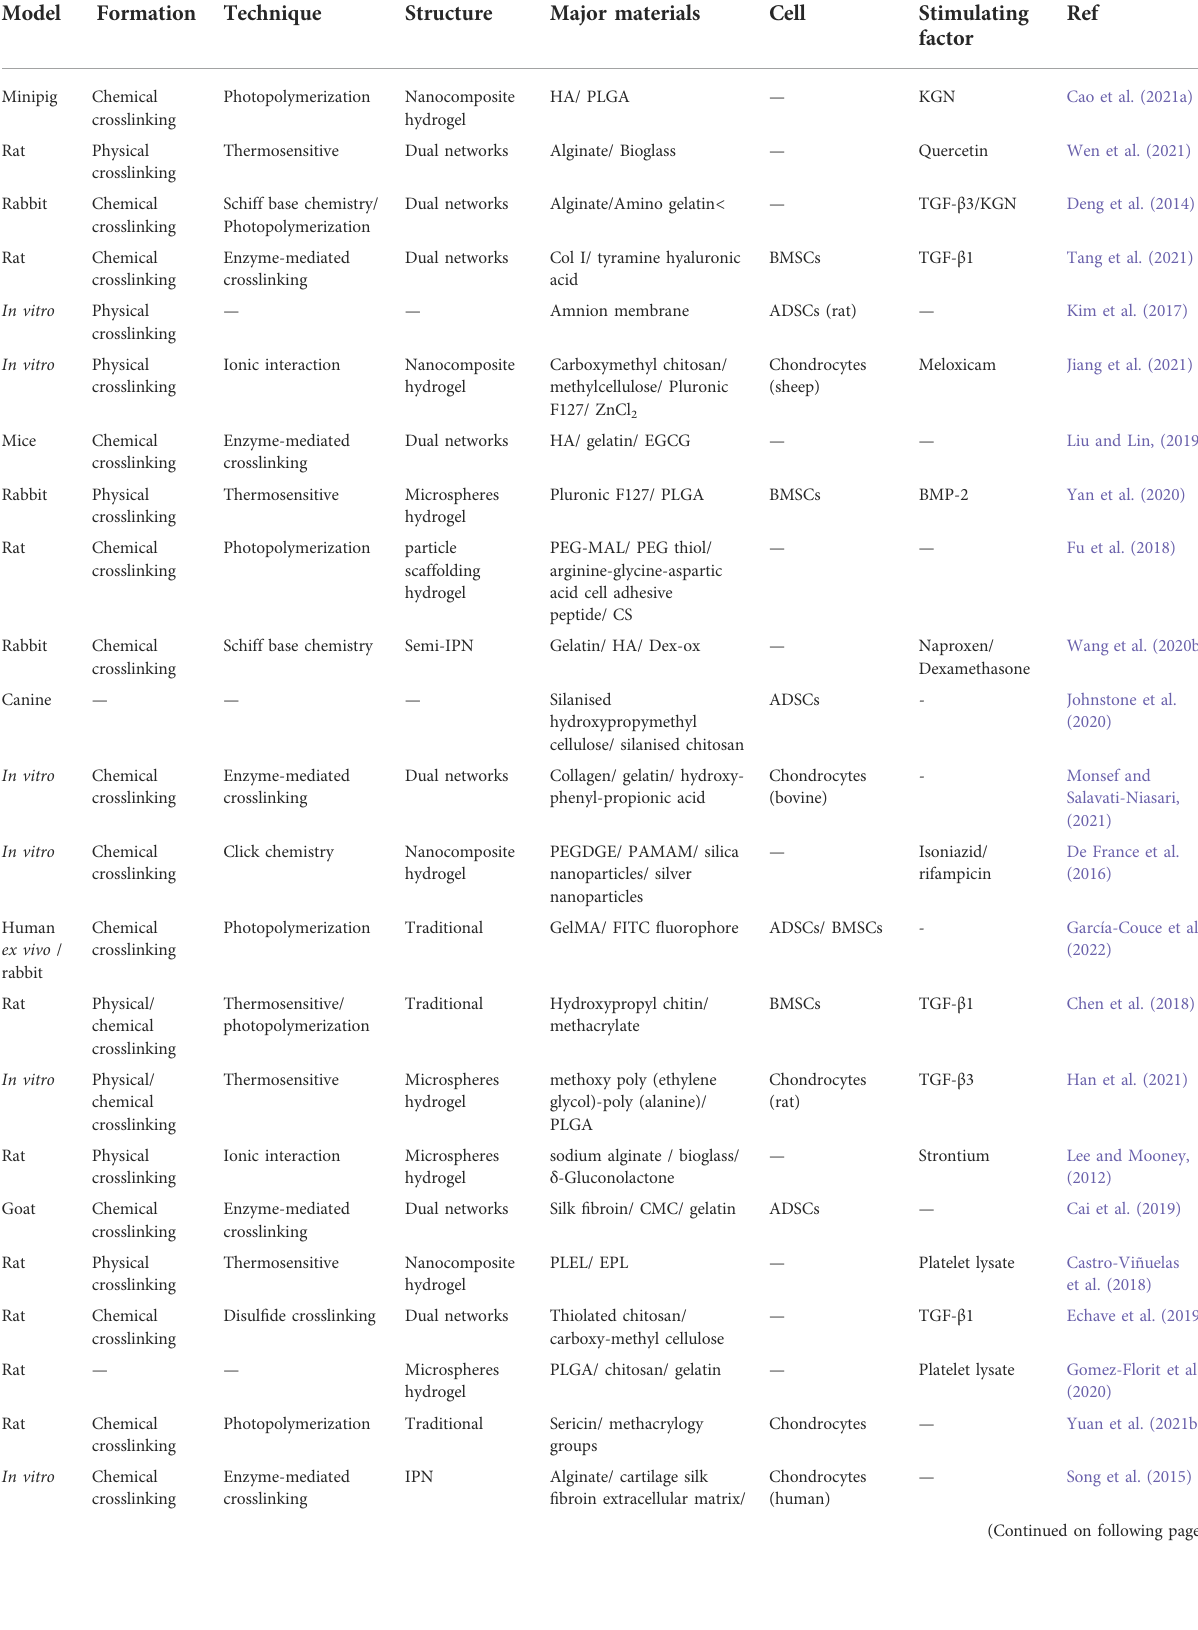
TABLE 1 Application of some advanced injectable hydrogels in cartilage tissue